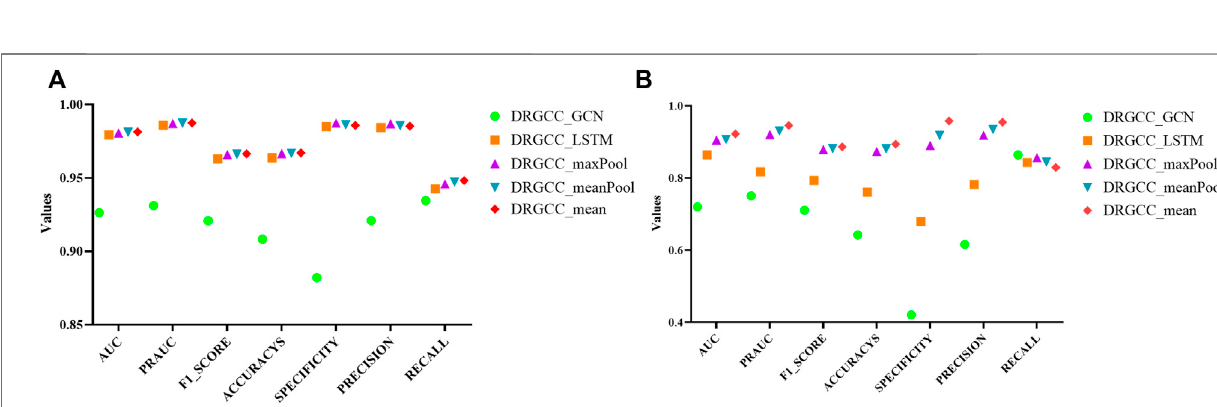
Frontiers in Pharmacology |